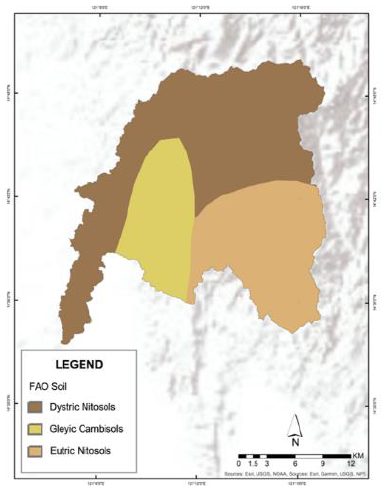
Figure 4. Marikina River Basin FAO Soil Map.